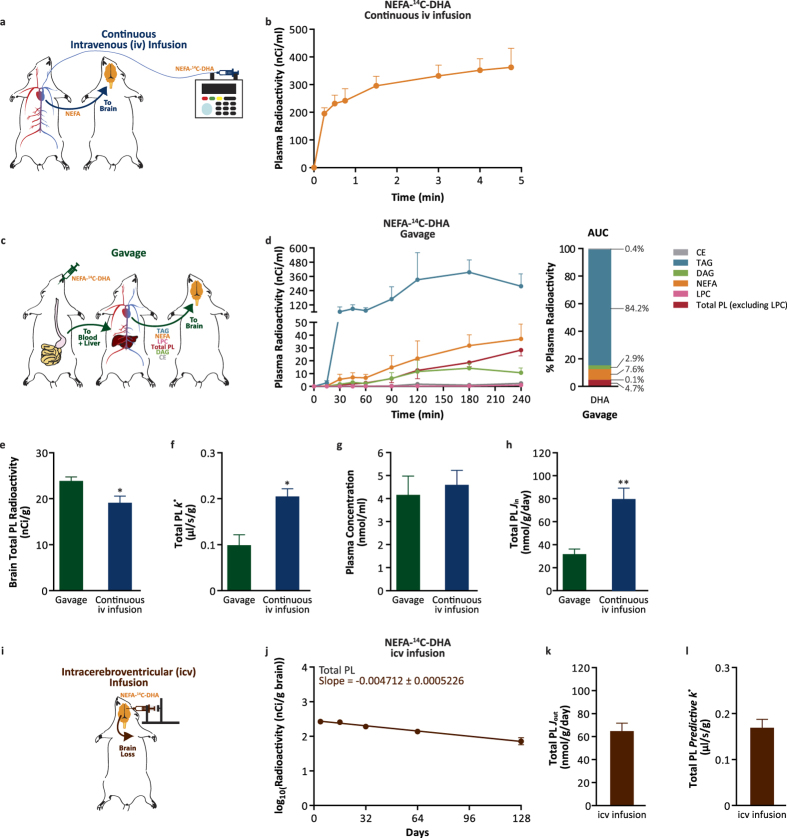
NEFA-DHA uptake by the brain.(a) Schematic diagram of kinetic modeling following continuous intravenous (iv) infusion. (b) Plasma lipid radioactivity upon continuous iv infusion of 86 μCi NEFA-14C-DHA over 5 minutes (n = 6). Radioactivity from other plasma lipid pools was below detection, 23 pCi. (c) Schematic diagram of kinetic modeling following NEFA-14C-DHA gavage. (d) Plasma lipid radioactivity upon NEFA-14C-DHA oral gavage over 4 hours (n = 4) and the percent composition of total radiolabeled lipid pools in the plasma post-gavage of NEFA-14C-DHA. (e) Brain radioactivity of total phospholipids from rats gavaged or continuously iv infused with NEFA-14C-DHA. (f) The uptake incorporation coefficient of NEFA-14C-DHA (k*) into brain total phospholipids from rat gavage or continuous iv infusion. (g) The plasma concentration of NEFA-DHA prior to NEFA-14C-DHA gavage or continuous iv infusion. (h) The net incorporation rate of DHA (Jin) to brain total phospholipids from rats gavaged or iv infused with NEFA-14C-DHA. (i) Schematic diagram of kinetic modeling following intracerebroventricular (icv) infusion. (j) Brain loss curve of esterified 14C-DHA from brain total phospholipids including lysophosphatidylcholine over 128 days (n = 3–4 independent samples per time point). (k) The loss of DHA from brain total phospholipids (rate of loss, Jout) from rats infused icv with NEFA-14C-DHA which was not significantly different from the Jin of rats continuously iv infused with NEFA-14C-DHA. (l) Calculated predictive k* from the NEFA-14C-DHA icv infusion which was not significantly different from k* from NEFA-14C-DHA iv infusion. All data are expressed as mean ± SEM; whereas percent plasma radioactivity data are expressed as mean. *P < 0.05 and **P < 0.01 indicate significant difference from gavage using Students’ t-test. AUC, area under the curve; CE, cholesteryl ester; DAG, diacylglycerol; LPC, lysophosphatidylcholine; NEFA, non-esterified fatty acid; PL, phospholipids; TAG, triacylglycerol.